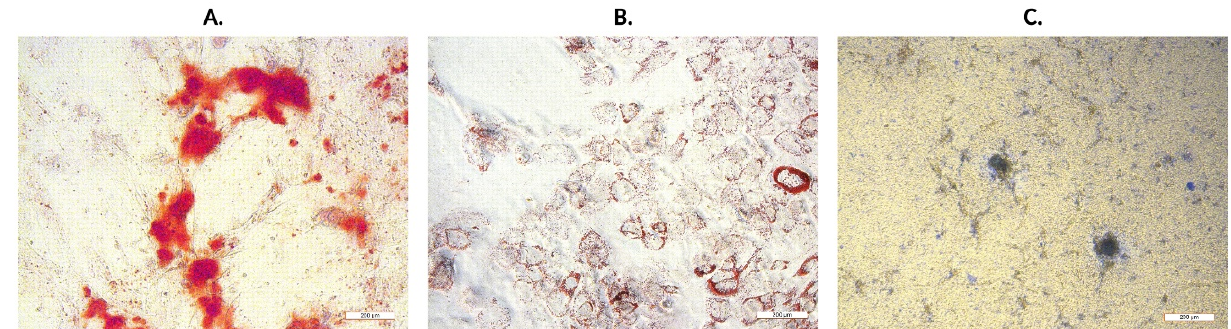
Figure 3. Microscopic images of CHo-MSCs (passage P4) after 21 days in differentiation medium. ( A ) Osteogenic differenti- ation detected by Alizarin Red S staining of calcium oxalates; ( B ) Adipogenic differentiation detected by Oil Red O staining of lipid vacuoles; ( C ) Chondrogenic differentiation detected by Alcain Blue staining of proteoglycans in differentiated human CHo-MSCs. Images were obtained on an inverted fluorescence microscope Leica DMI3000B using a 10 × objective. Scale bars = 200 µm.